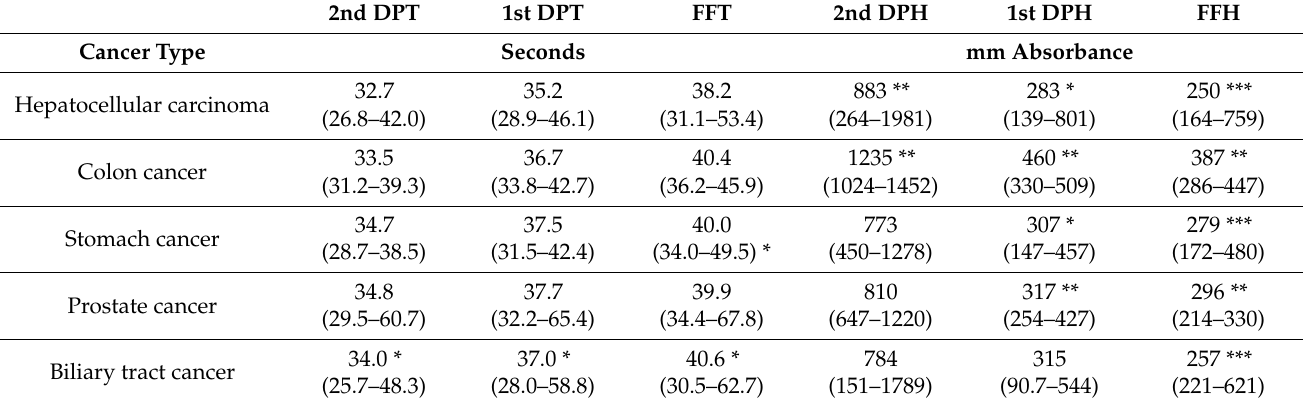
Table 2. CWA-APTT in patients with malignant